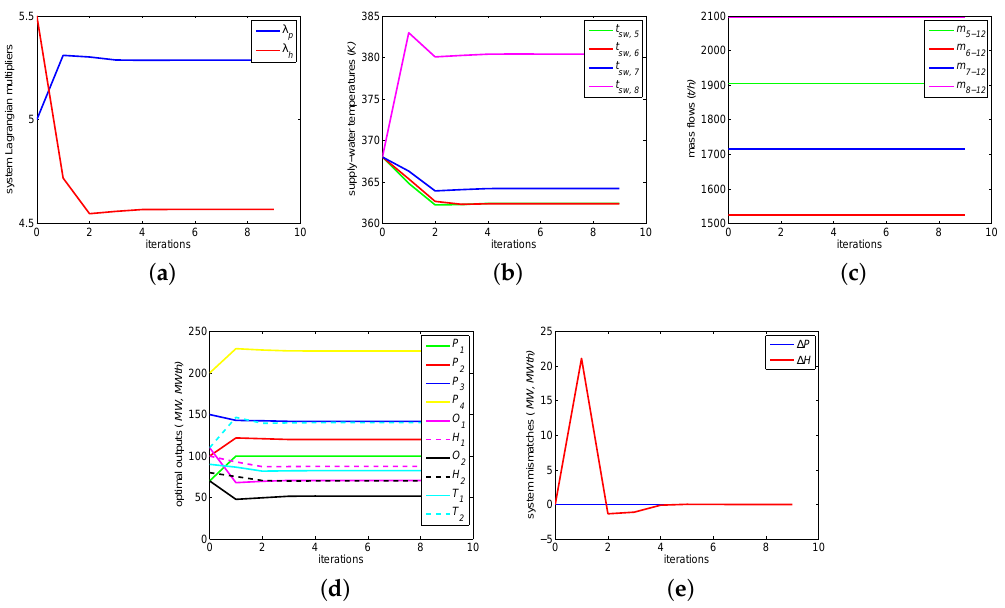
Figure 5. Case study 2: With output inequality constraints. ( a ) system Lagrangian multipliers; ( b ) supply-water temperatures; ( c ) mass flows; ( d ) optimal outputs; ( e ) system mismatches.